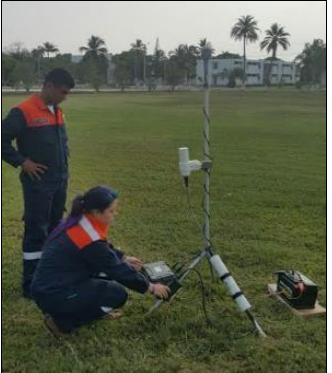
Figure 2. Installation of the Geometrics G-862 RBS Base Station.